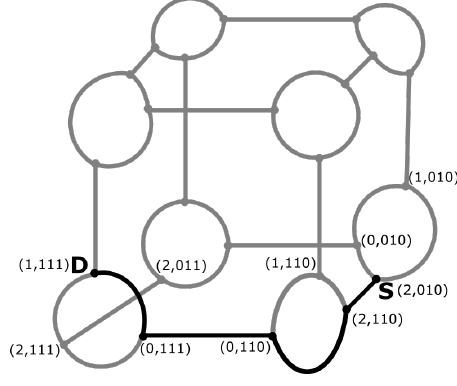
Figure 3. Routing presentation in Cube Connected